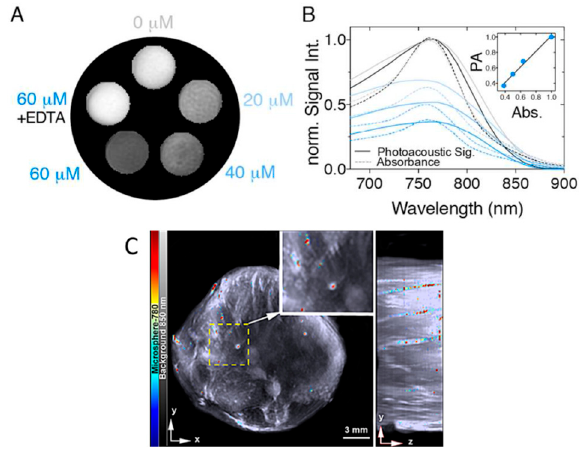
Figure 8. IR780-based probes have the potential to detect concentrations of calcium and serve as a tracking dye for monitoring microparticle accumulation. ( A , B ) Response of an IR780 based probe to calcium concentration. As calcium concentration increases, both absorbance and optoacoustic signal decrease. Figure from [82]. ( C )—MSOT imaging of IR780 impregnated polystyrene microspheres in mouse liver after ileocolic vein injection. Figure from [83] reproduced with permission from the